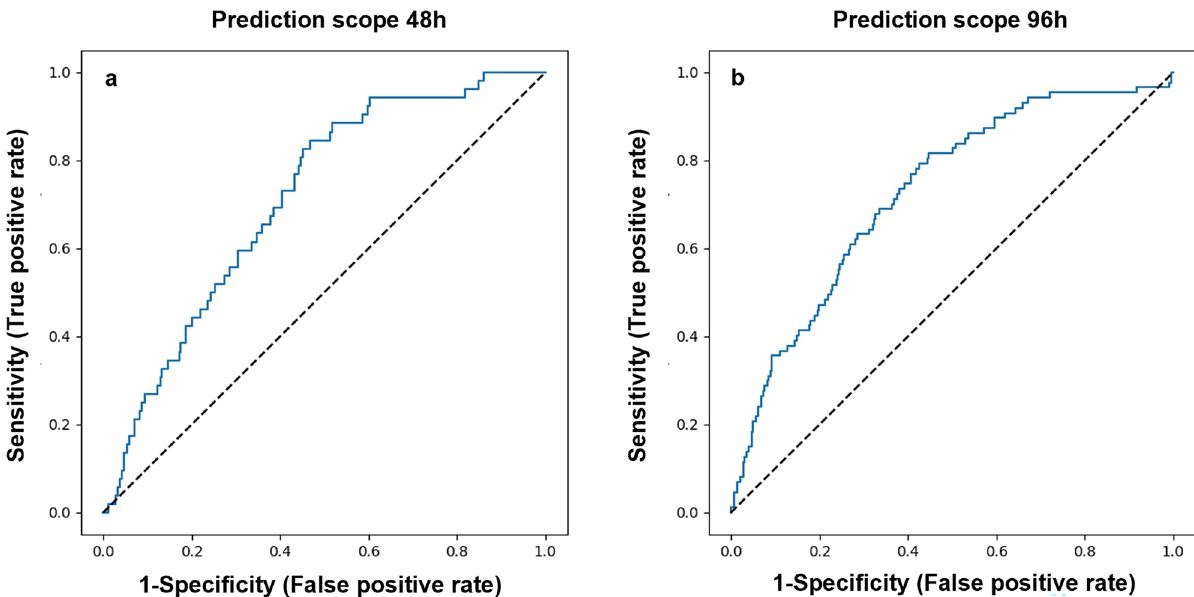
Figure 4. External validation results. Model accuracy, measured on the external validation dataset from Barzilai University Medical Center, as shown in the ROC curves, for prediction scopes of ( a ) 48 h and ( b ) 96